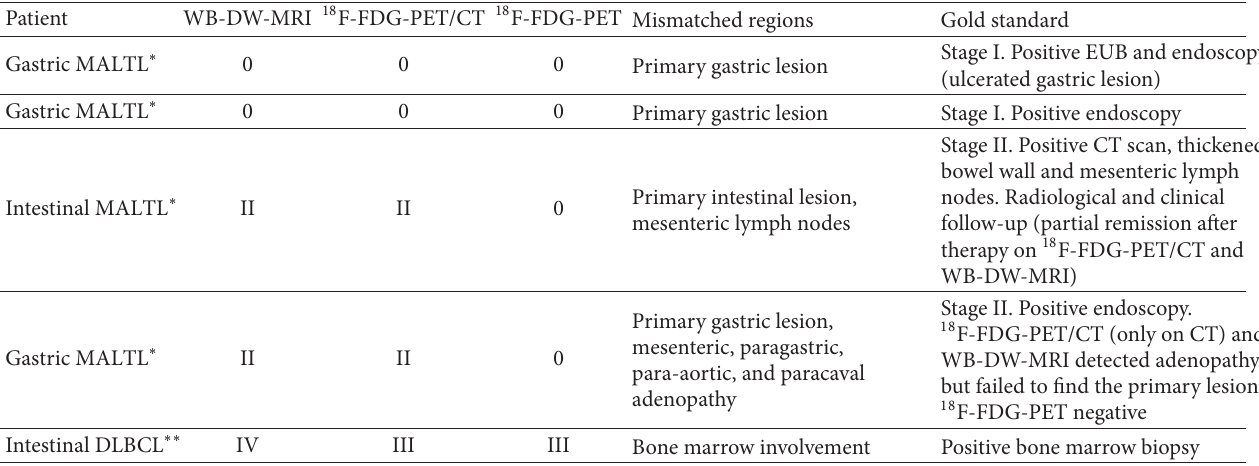
Figure 1: A 38-year-old man with intestinal DLBCL (diffuse large B-cell lymphoma): (a) MIP image of 18 F-FDG-PET, (b) coronal whole-body CT, and (c) MIP image of DWI. All techniques detected the primary intestinal lesion (arrow). Table 4: Staging by both techniques: mismatched sites behind differences in staging with respect to standard of